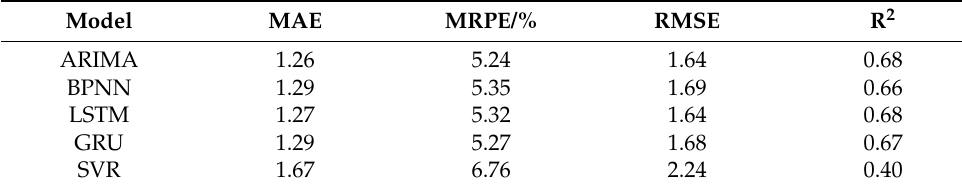
Table 3. Performance comparison of different